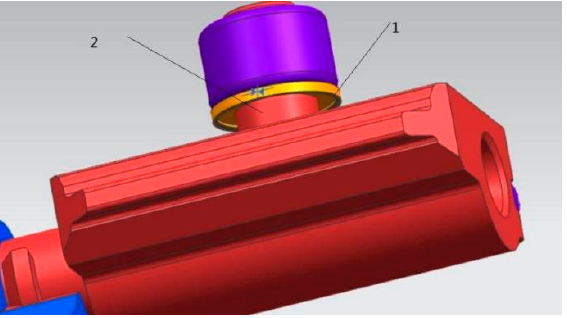
Figure 18. The bolt motion analysis with clearance and recoil. Note: 1—bolt body, 2—the rolling axis.